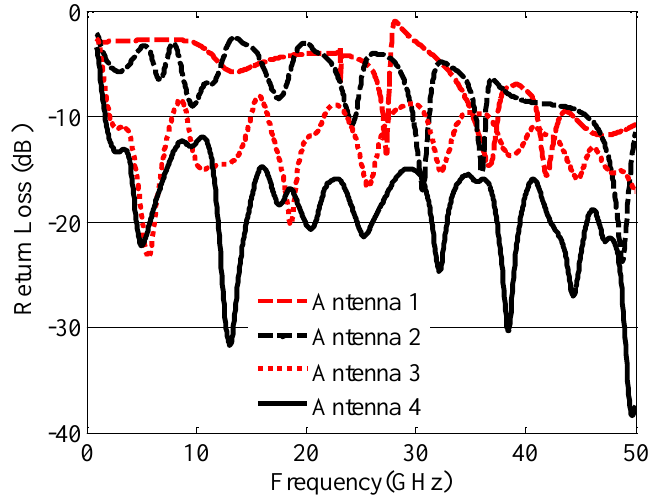
Figure 2. The simulated return loss for designed SWB antennas in Figure 1.